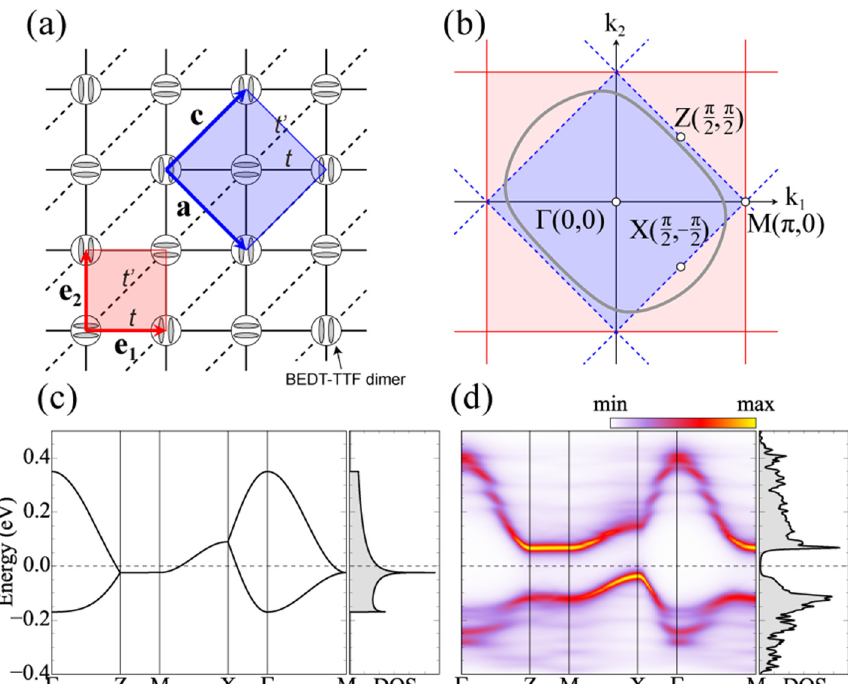
Figure 2. Unit cells, Brillouin zones, band structure, and single-particle spectral functions of κ -Cl. Note that the calculations are based on the one-band model. However, the band structure and the spectral functions are shown in the two-site Brillouin zone [blue shaded area in ( b )] because the adjacent BEDT-TTF dimers are not completely equivalent in the material. Accordingly, the X, Z, and M points in ( c ) and ( d ) correspond to points ( π /2, − π /2), ( π /2, π /2), and ( π , 0) in the Brillouin zone of the one-site unit cell. ( a ) Schematic of the anisotropic triangular lattice of κ -Cl. Translational vectors e 1 and e 2 ( a and c ) are represented by red (blue) arrows. The red (blue) shaded region represents the unit cell containing one site (two sites). The ellipses on the sites denote the conducting BEDT-TTF dimers. ( b ) The momentum space for the anisotropic triangular lattice. The Brillouin zones of the one- (two-) site unit cell are represented by the red (blue) shaded region bounded by the red solid (blue-dashed) lines. The solid gray line indicates the FS. ( c ) Noninteracting, tight-binding band structure along highly symmetric momenta and density of states (DOS) of κ -Cl ( 𝑡′/𝑡 = −0.44 with 𝑡 = 65 meV ). The Fermi level for half filling is set to zero and denoted by the dashed lines. ( d ) Single-particle spectral functions and DOS of κ -Cl at half filling in the antiferromagnetic state at zero temperature, calculated by variational cluster approximation [5]. The Fermi level is denoted by the dashed lines at zero energy. Reproduced with permission from [6].